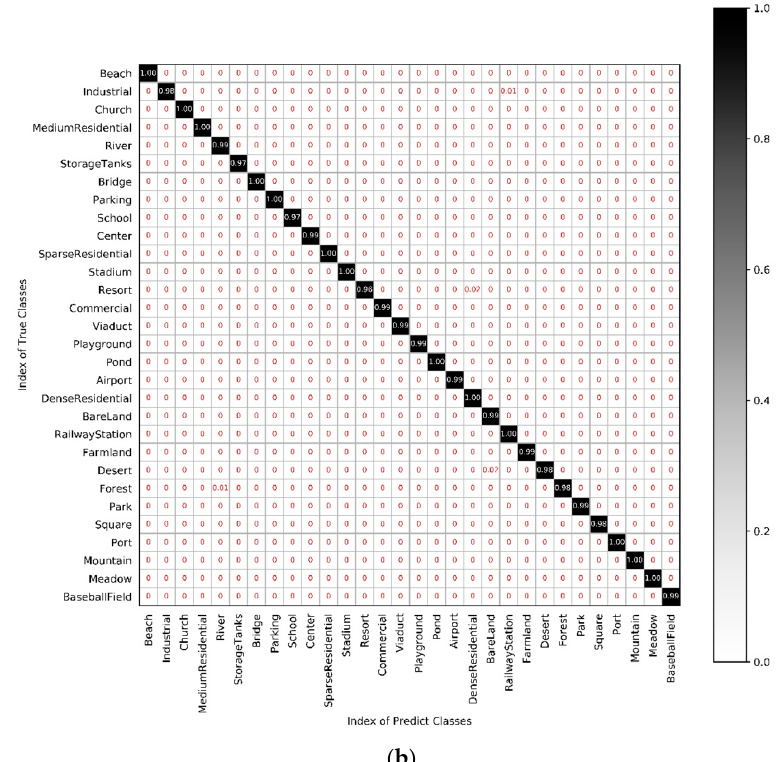
Figure 9. Confusion matrix of the proposed method on the UCM dataset and AID dataset: ( a ) UCM dataset; ( b ) AID